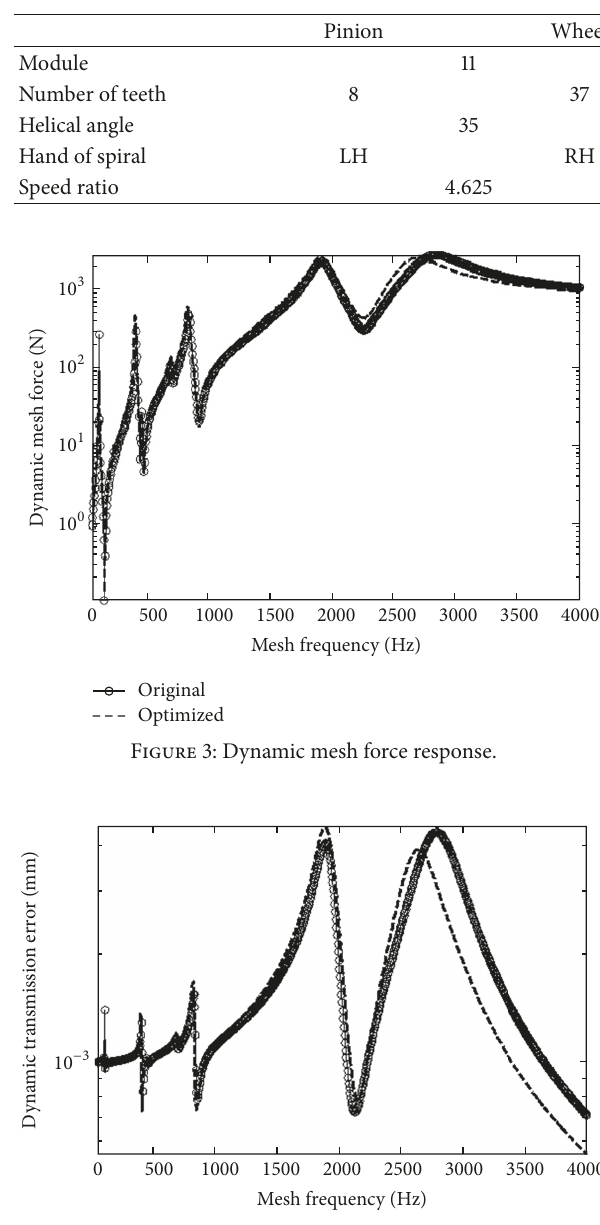
Table 4: Design parameters of spiral bevel gear.